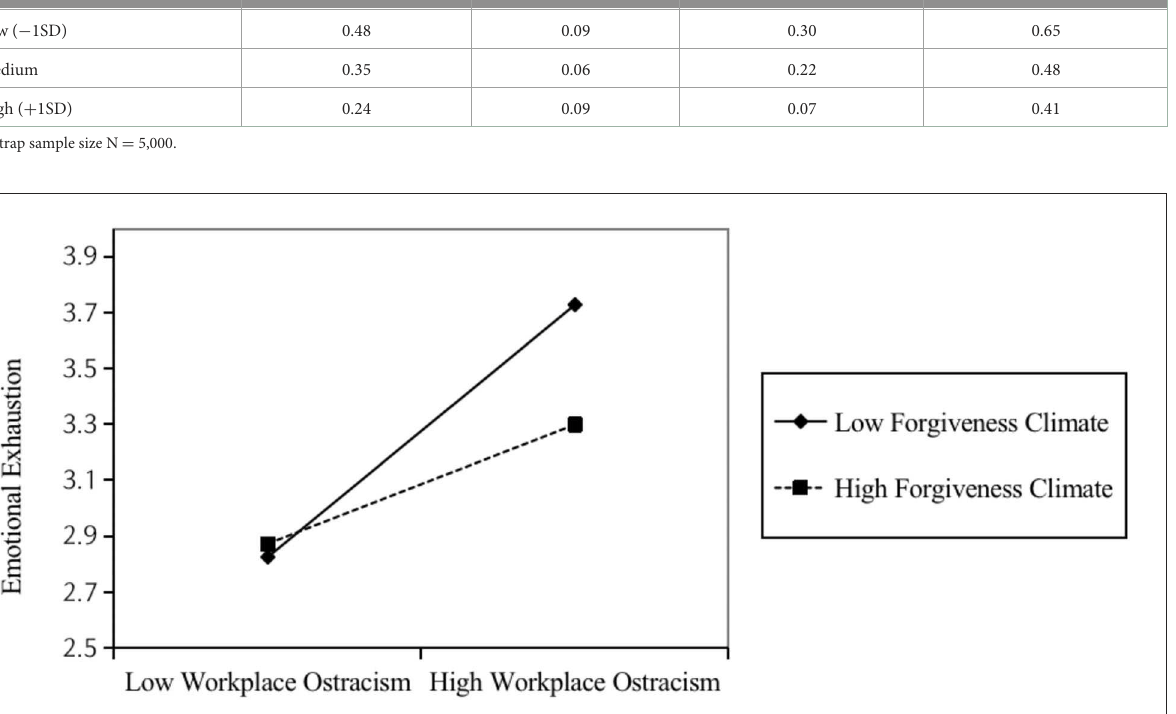
high and low levels of the moderating variables. According to Figure 2, the positive relationship between workplace ostracism and emotional exhaustion is weaker at higher levels of the forgiveness climate. Hypothesis 3 is, thus,